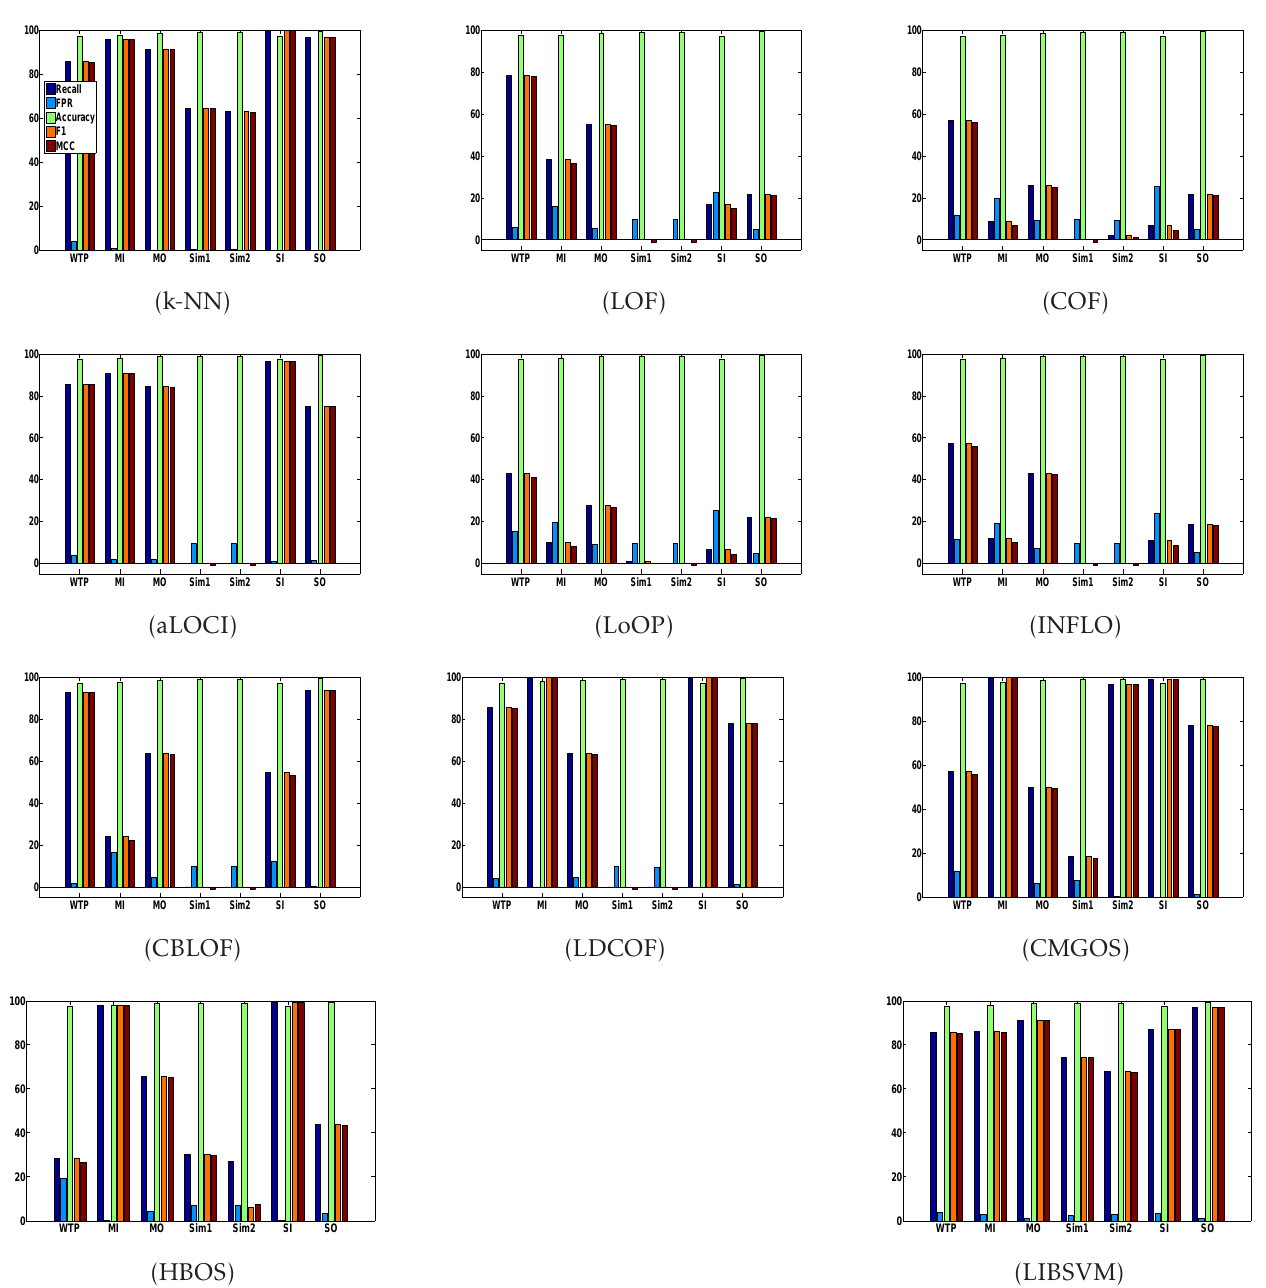
Figure 11. Performance of anomaly detection techniques on SCADA datasets, scaled to 0